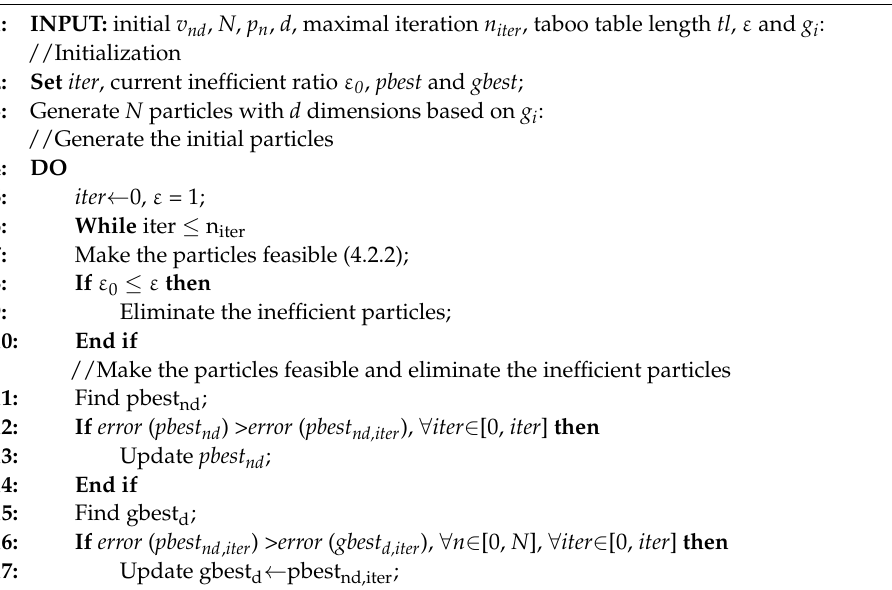
Algorithm 1: Improved PSO algorithm